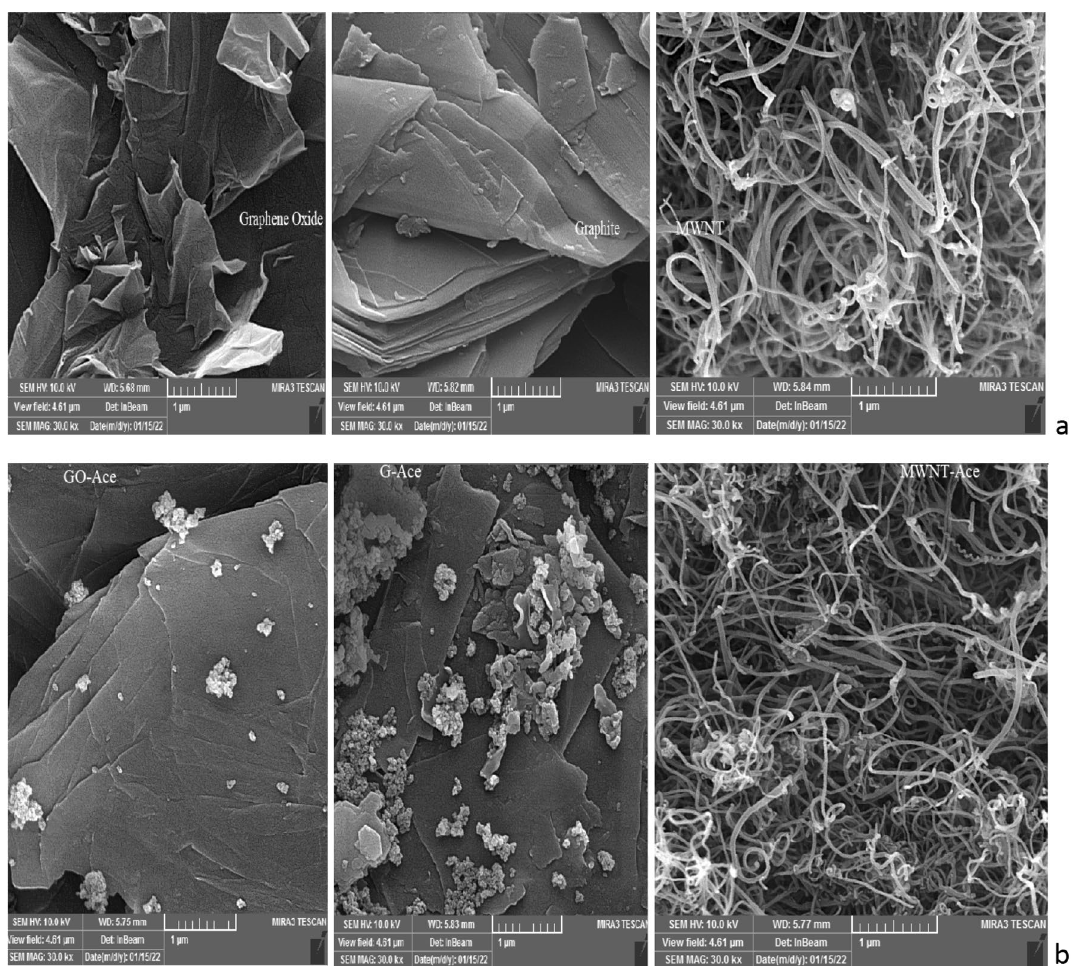
Figure 9. Surface of adsorbent: ( a ) before adsorption of acetamiprid ( b ) after adsorption of acetamiprid.